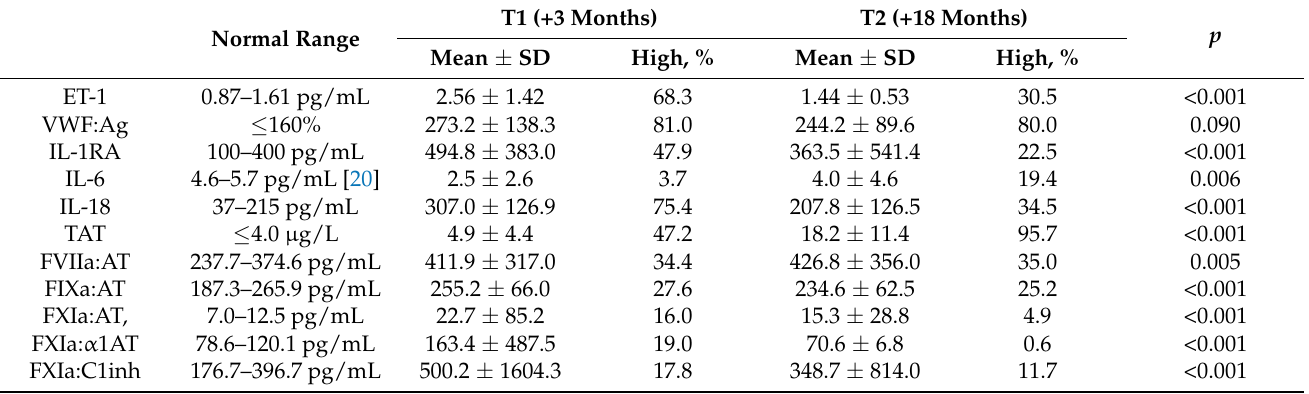
Table 3. Endothelial cell activation, circulating inflammatory cytokines, and markers of coagulation system activation at 3 months versus 18 months after recovery of acute